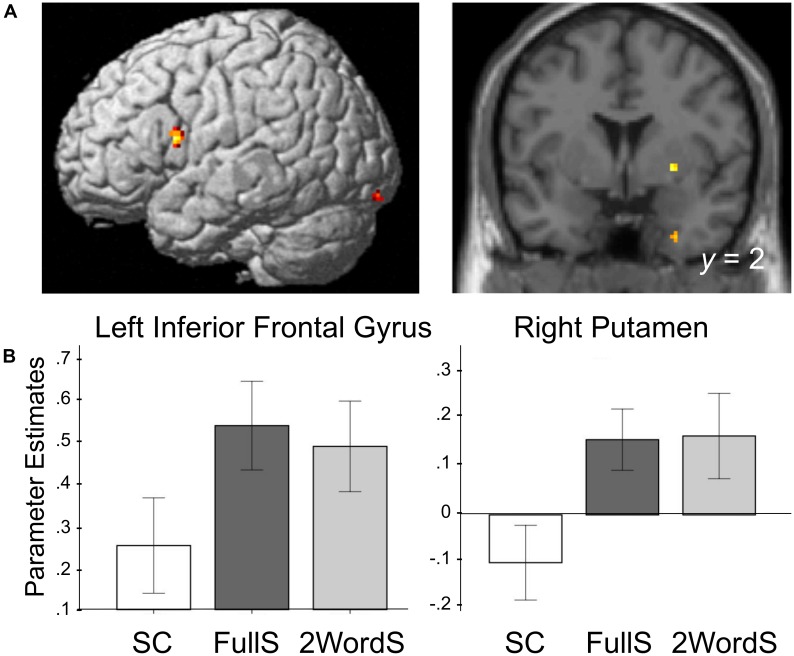
Processing of Small Clauses is associated with reduced activation in the left IFG (BA 44) and the right putamen. (A) Activation maps are rendered on a brain template depicting brain regions in which activation for Small Clauses was lower compared to activation for Full Sentences and for Two-word Sentences. These brain regions include regions in the Inferior Frontal Gyrus (x = –48, y = 8, and z = 16) and the Putamen (x = 26, y = 2, and z = –2). Conjunction analysis was made using contrast maps of Small Clauses compared to Full Sentences, and Small Clauses compared to Two-word Sentences, each threshold at p < 0.005 (conjunctive p < 0.000025). Clusters identified by the conjunction composed of at least 9 contiguous voxels are reported. (B) Mean parameter estimates per condition extracted from the functionally defined regions of interest identified in the conjunction analysis shown in A. SC, Small Clauses; FullS, Full Sentences; 2WordS, Two-word Sentences.